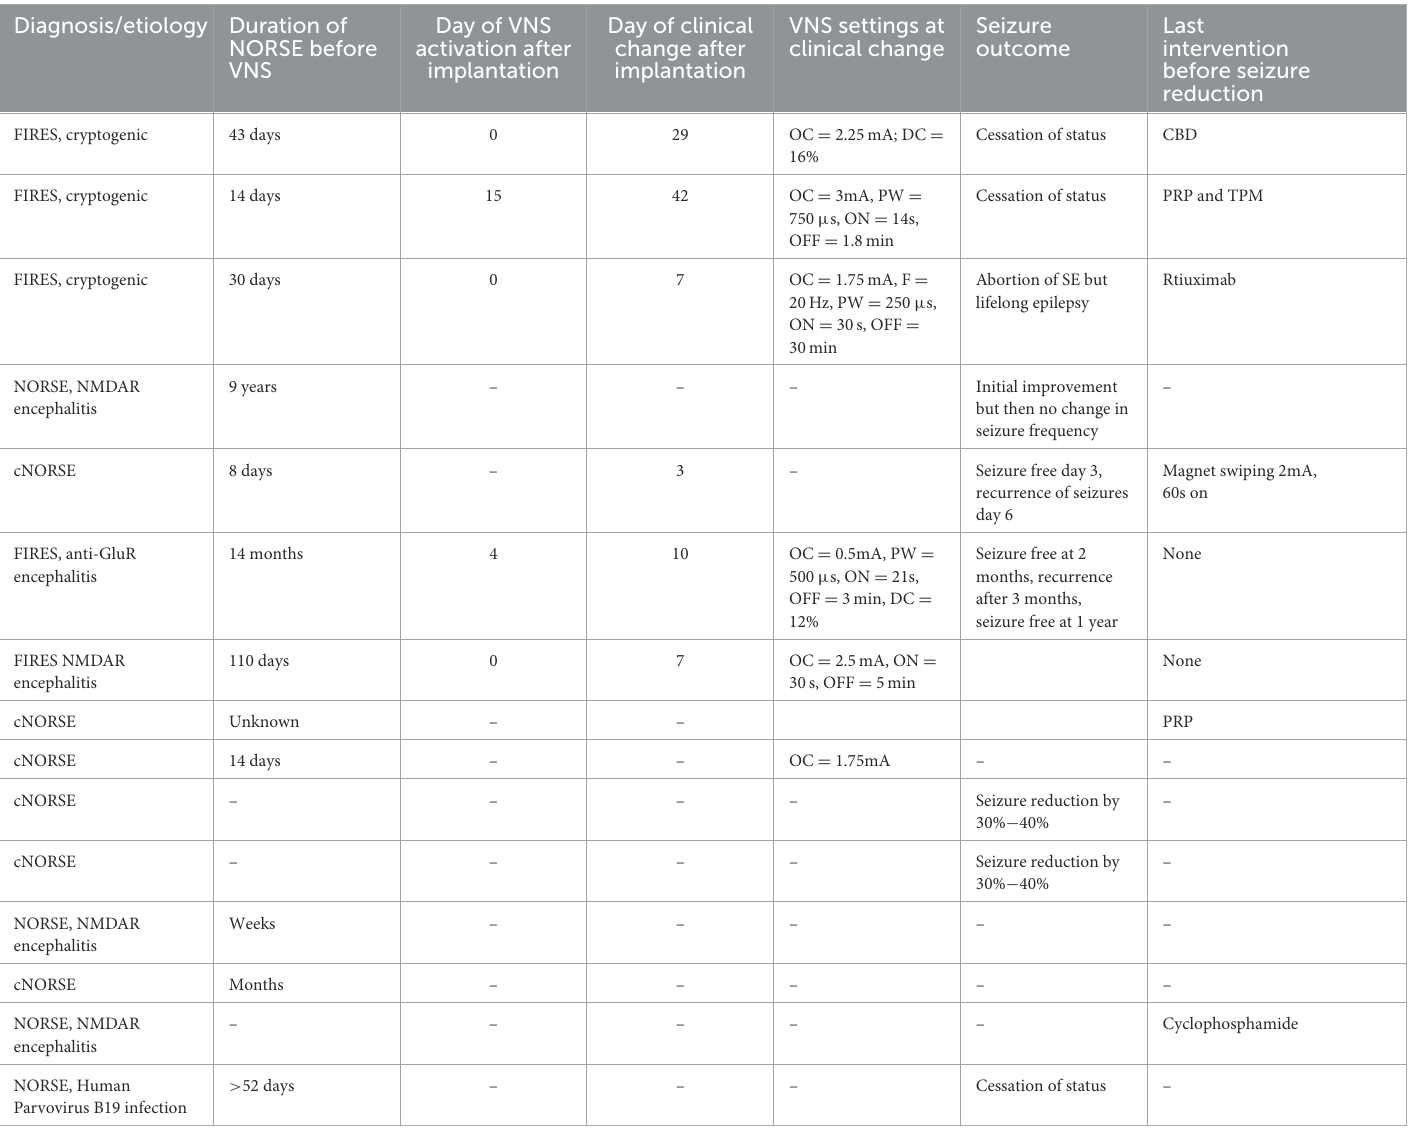
TABLE 1 Patient characteristics, details of VNS implantation and stimulation parameters in published NORSE